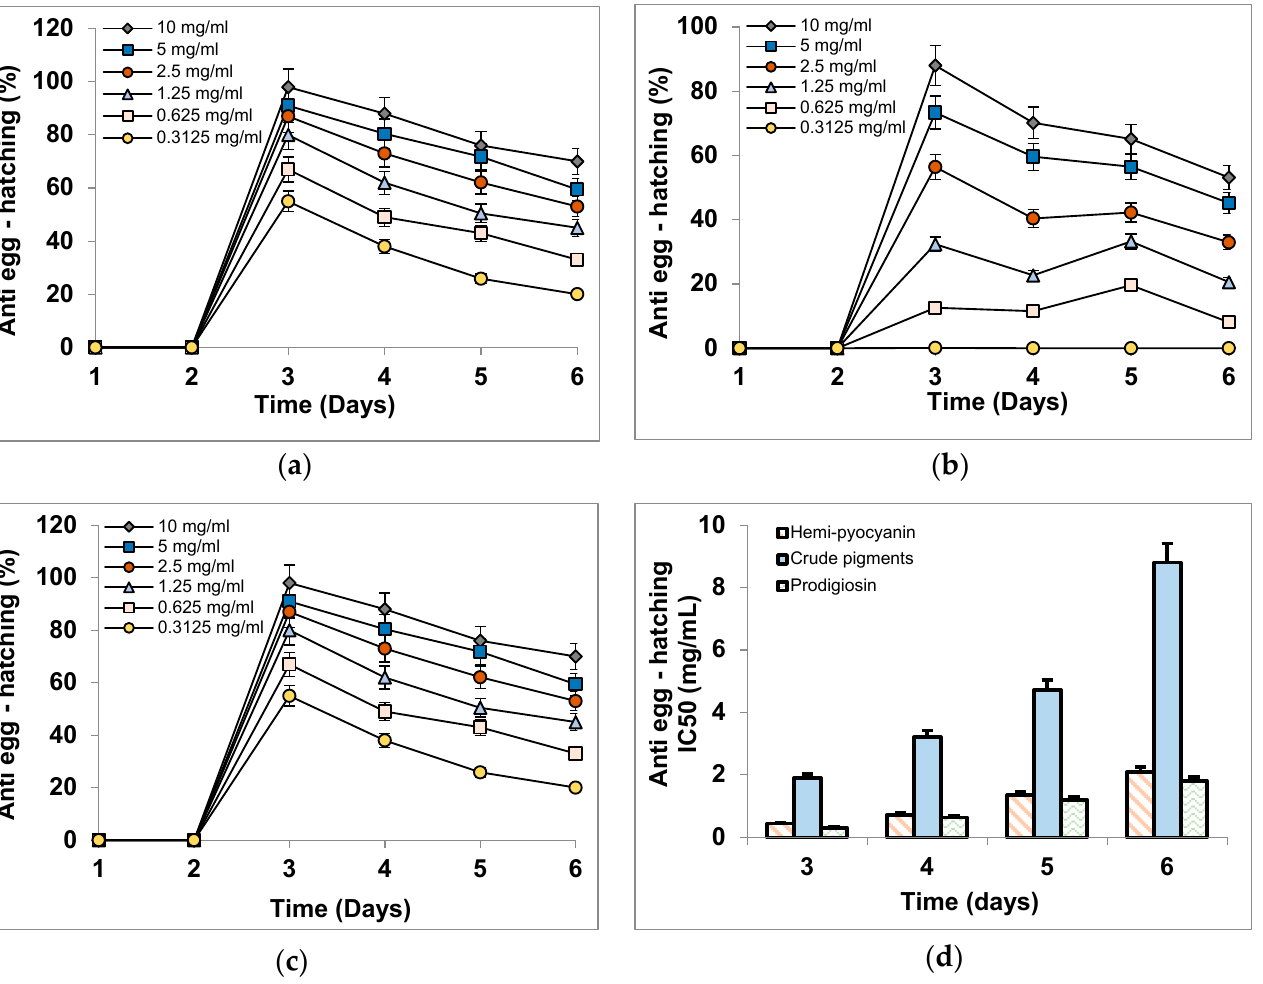
Figure 10. The egg-hatching inhibitory effect (%) of hemi-pyocyanin ( a ), crude pigments ( b ), and prodigiosin ( c ), and their effect was expressed as IC 50 values ( d ). The graph bioactivity was constructed by Microsoft Excel 2010. The nematode eggs were treated with six concentrations of samples (0.313, 0.625, 1.25, 2.5, 5, and 10 mg/mL) and followed up by counting the amount of egg hatching using stereoscopic microscope Olympus SZ5 for estimation of the activity during the 6 days of treatment. All the experiments were conducted in three repetitions.